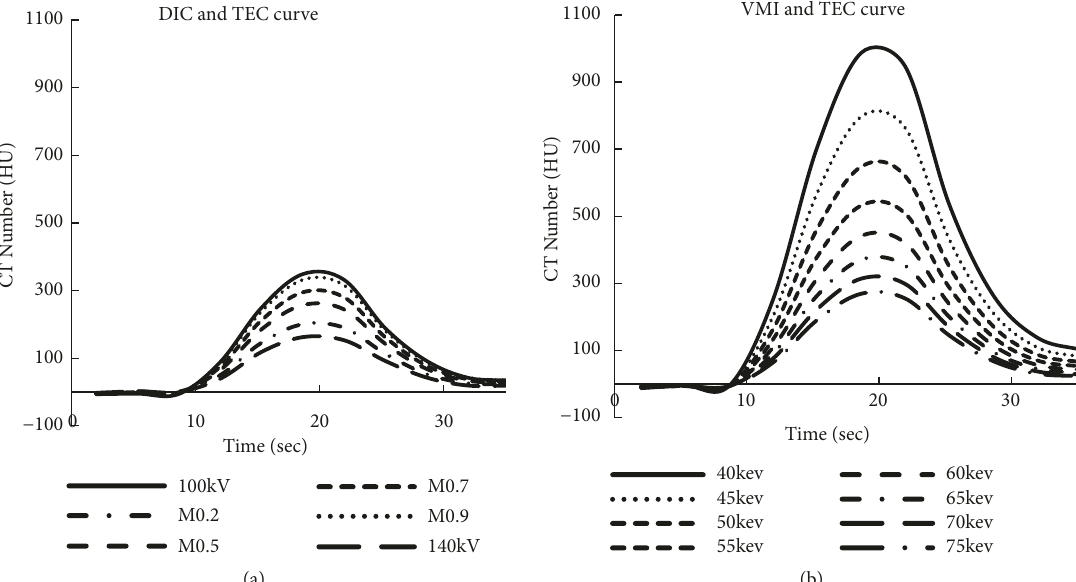
Figure 3: The DIC and VMI of the contrast media sensitivity. (a) The TECs of the DIC images, which show the differences among the mixing ratios of 100 kVp and 140 kVp. (b) The TECs of the VMI images, which show the differences among the monoenergetic energies. Injection condition: saline :contrast media, 0: 10.